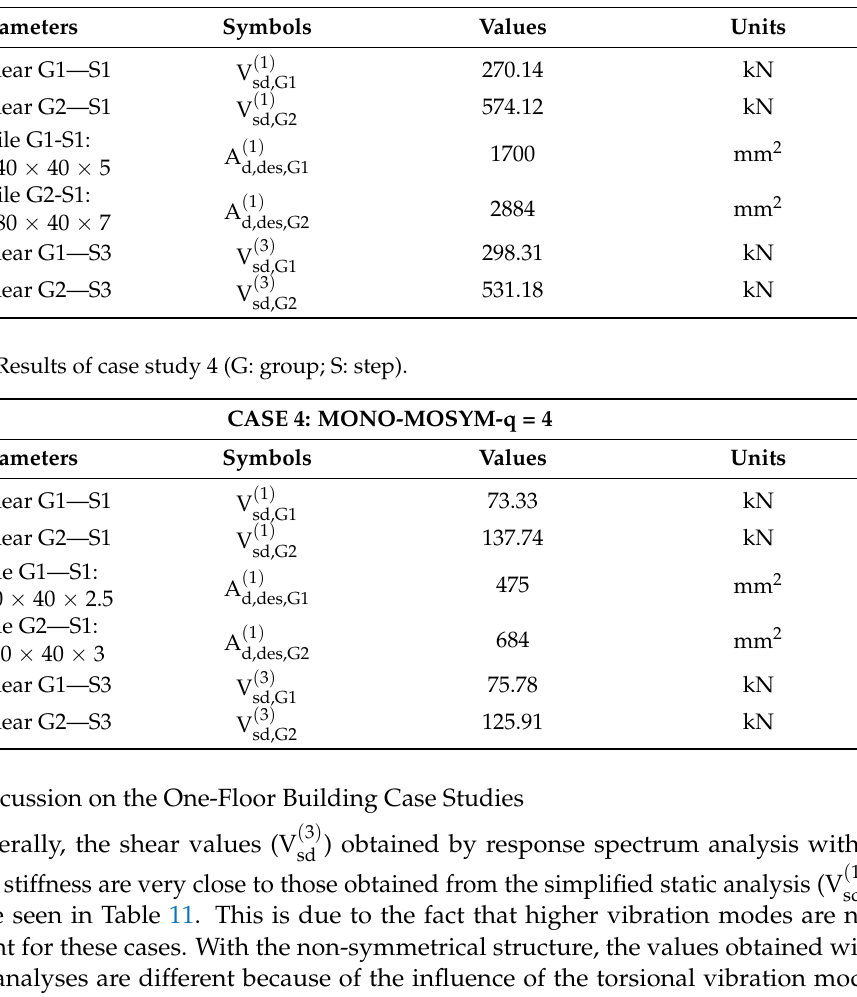
Table 10. Results of case study 4 (G: group; S: step).